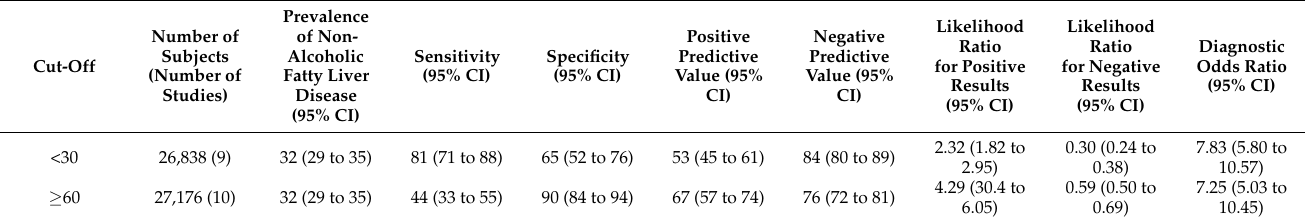
Figure 2. Forest plot of the sensitivity and specificity of fatty liver index in identifying non-alcoholic fatty liver disease according to the lower and the higher cut-off. FLI, fatty liver index; FN, false negative; FP, false positive; TN, true negative; TP, true positive; 95% CI, 95% confidence interval. References: Koehler, 2013 [12], Zelber-Sagi, 2013 [13], Arteaga, 2014 [14], Carvalho Goulart, 2015 [15], Huang, 2015 [16], Procino, 2018 [17], Chen, 2020 [18], Jung, 2020 [19], McHenry, 2020 [20], Murayama, 2021 [21]. Table 2. Summary estimates of the fatty liver index in identifying non-alcoholic fatty liver disease according to the lower and the higher